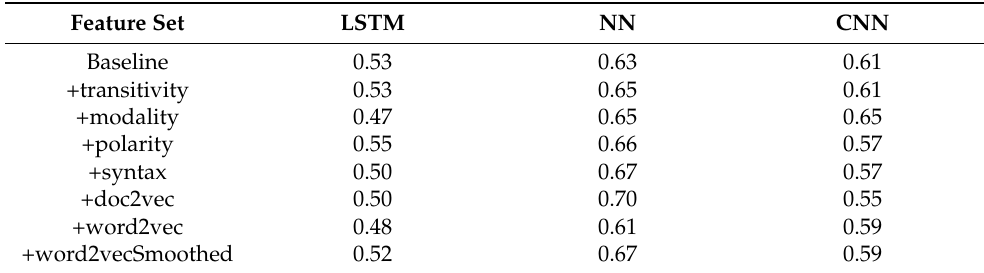
Table 7. Classification of problems from non-problems using deep learning networks by 5-fold cross validation.